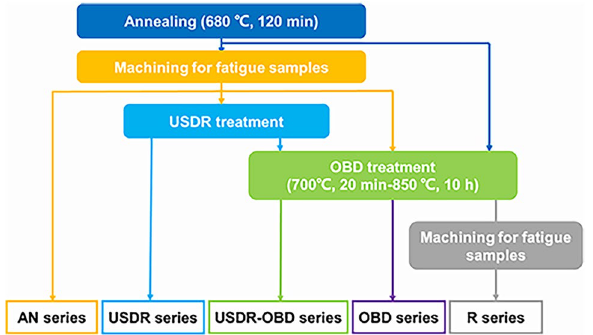
Figure 1. The flow chart of preparation process for 5 series